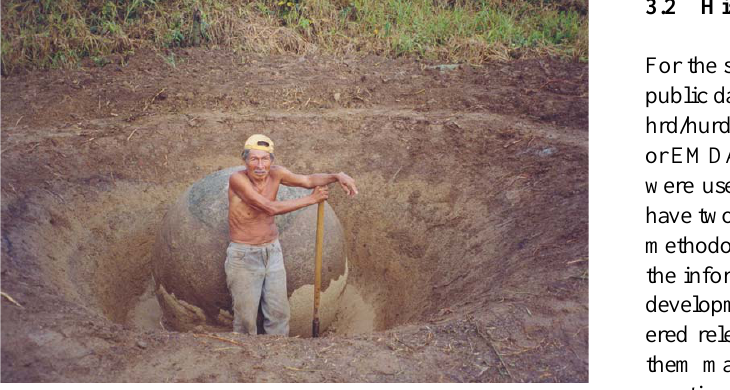
Fig. 2. Stone sphere of approximately 1.5m. in diameter located currently in Finca 6, in southern Costa Rica (courtesy of Costa Rica archeologist Ifigenia Quintanilla). Note the different soil layers around the sphere, presumably as a result of floods and